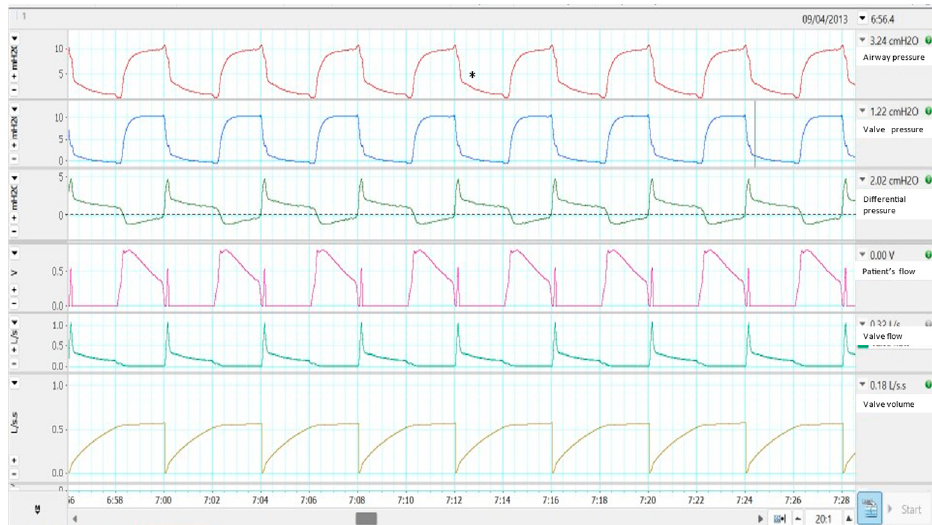
Figure 1. Performance of a single limb system with active valve in a bench test. See the text for more details. Asterisk displays the slower despressurization in the airway pressure than in the valve (channel 2)